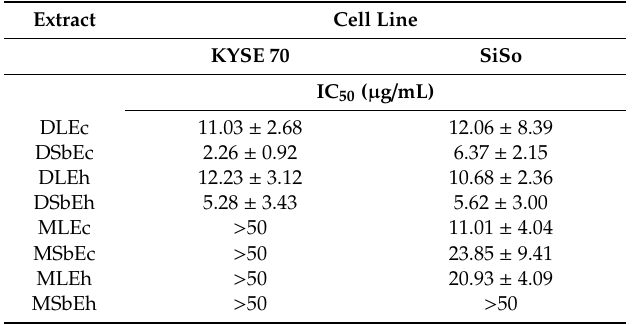
Table 5. IC 50 of extracts on KYSE 70 and SiSo cell lines in secondary screening. Extract